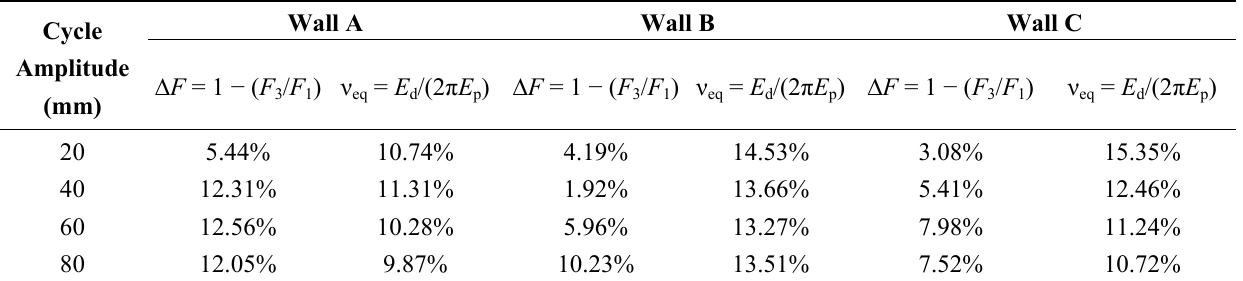
Table 3. Strength degradation and equivalent viscous damping at each cyclic amplitude.